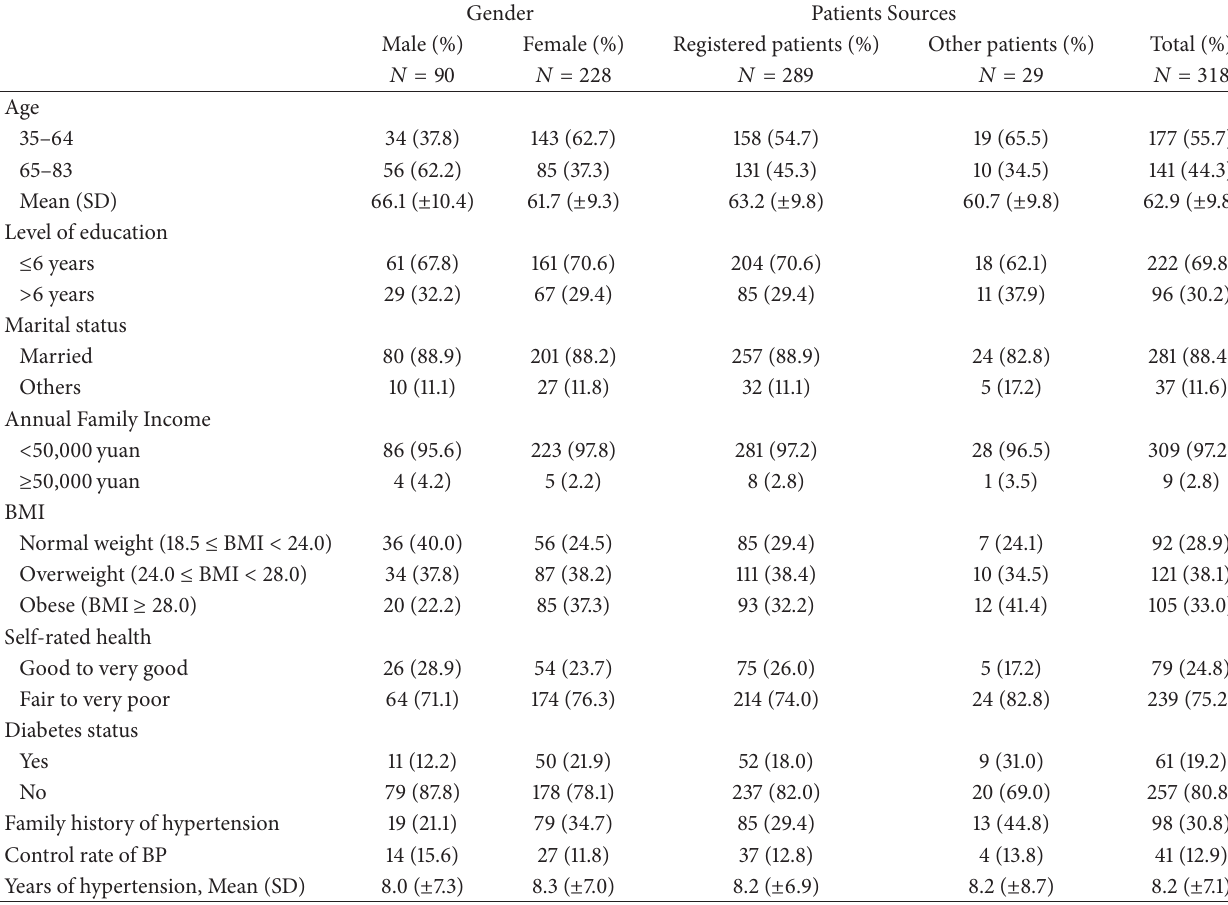
Table 1: Characteristics of respondents in a rural hypertension population in Beijing,